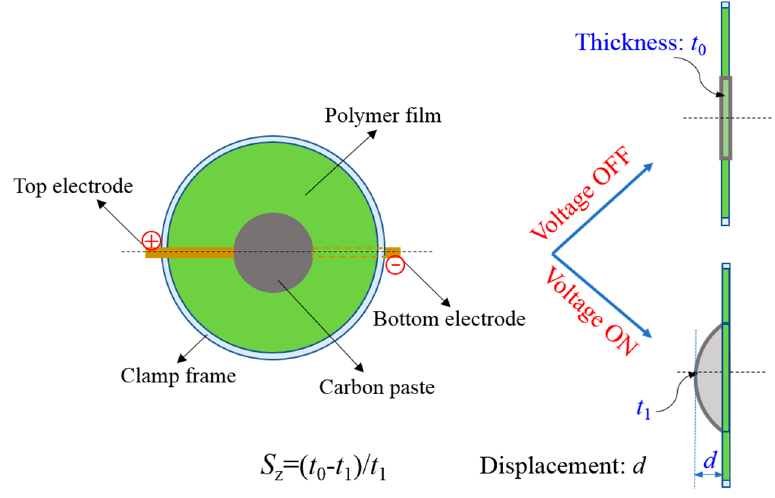
Figure 7. Schematic illustration for measurement of the electromechanical response.